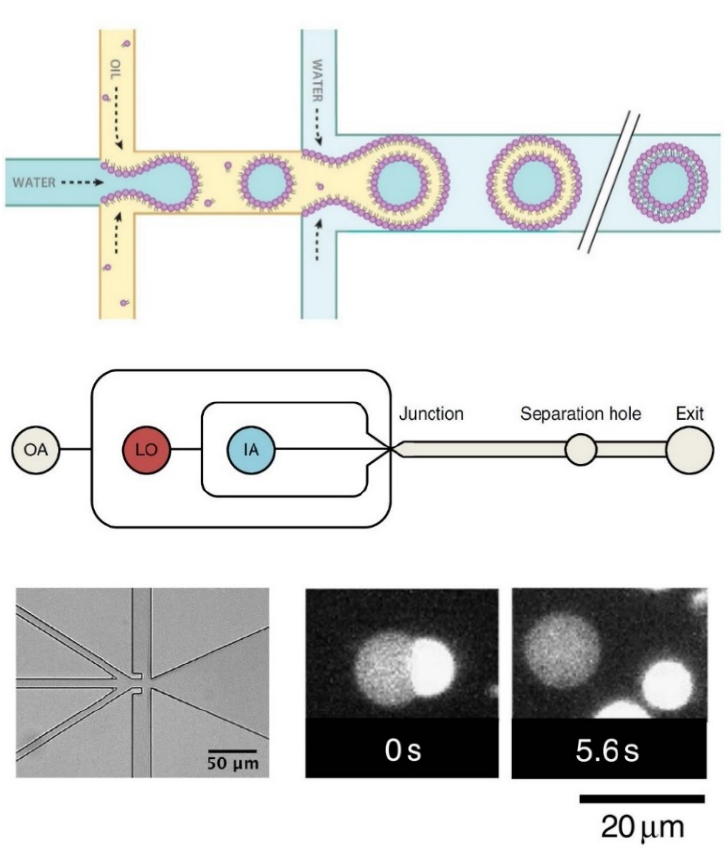
Figure 20. The use of microfluidics for the formation of GUVs. Top: Schematic representation of one of the microfluidics methods for the preparation of GUVs, as published by Litschel and Schwille (2021) [264]. The concept of the method is related to the conventional w / o / w -double emulsion method illustrated in Figure 17b. The key difference between the conventional method and the microfluidic method is that in the case of the microfluidic method the w / o / w -double emulsion is prepared in a very controlled way—droplet-by-droplet—on a microfluidic chip from an aqueous internal solution (dark blue “water”), an “oil” containing the amphiphiles (yellow “oil”)—which finally form the membrane of the GUVs—and an external aqueous solution (light blue “water”). In contrast to the microfluidic LUV formation by the “ethanol injection method”, where ethanol is used as water-miscible organic solvent (Figures 18 and 19), the “oil” used for the microfluidic GUV formation is a water-immiscible organic solvent (e.g., octanol in the presence of 15 vol.% glycerol [259,260]). The initially formed w / o / w -droplets consist of an internal aqueous solution, an amphiphile-stabilized oil layer, and an external aqueous solution. As final step, the oil needs to be removed. Middle: Scheme of the chip used by Deshpande et al. (2018) [260], with OA, LO, and IA being the “outer aqueous solution”, the “lipid-carrying oil”, and the “inner aqueous solution”, respectively. Bottom: Details of the chip (bar: 50 µ m) [260] and fluorescence microscopy images (bar: 20 µ m) showing the spontaneous removal of the “oil” octanol (originally containing 15 vol.% glycerol and 2 mg/mL DOPC with 0.1 mol% of a fluorescently labelled PE) from the vesicles by a budding process that occurs due to interfacial forces acting on the droplets [259]. The octanol droplet (bright sphere) separates from a w / o / w -double emulsion droplet ( t = 0 s) and results in the formation of an almost octanol-free GUV and a separated octanol droplet (at t = 5.6 s). The fluorescently labeled PE was DOPE-LissRhod, whereby “LissRhod” stands for the -(N-(lissamine rhodamine B sulfonyl moiety). The chip used was prepared from vinyl-terminated PDMS, poly(dimethylsiloxane), and the surface was coated with PVA, poly(vinylalcohol) to make it hydrophilic [259,260]. Reproduced from [264], copyright © Annual